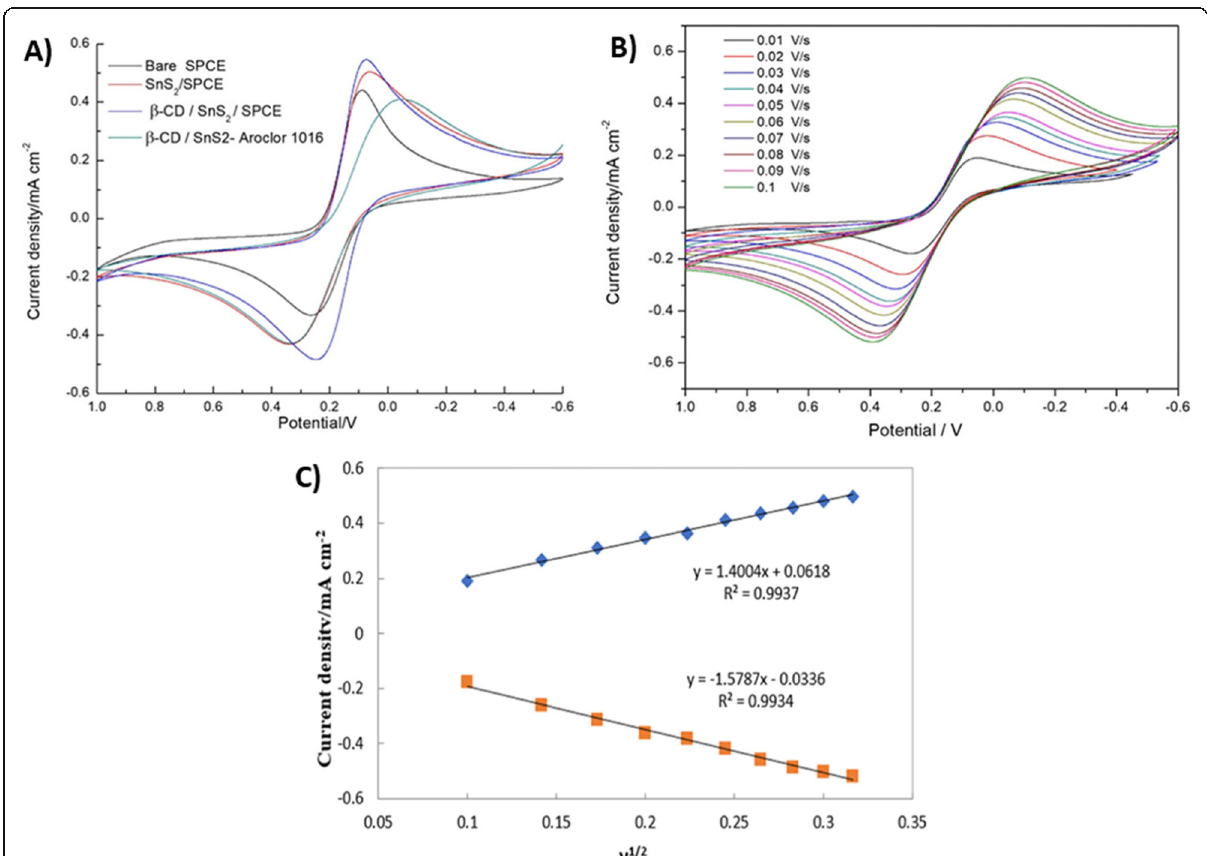
Fig. 6 a CV curves of the first three electrodes: bare SPCE, SnS 2 /SPCE, and β -CD/SnS 2 /SPCE in the electrolyte containing a mixture of 3 mM yellow blood salt, 3 mM red blood salt, 0.1 M KCl solution, and other β -CD/SnS 2 /SPCE in an electrolyte containing PCBs (Aroclor 1016) potential window from − 0.6 to 1.0 V with a scanning rate of 0.05 V/s. b CVs of different scan-rate analysis (0.01 V/s to 0.1 V/s) was carried out in 80 μ M PCBs (Aroclor 1016) in mixed solution of 3 mM yellow blood salt, 3 mM red blood salt, and 0.1 M KCl. c The calibration plot depicts the